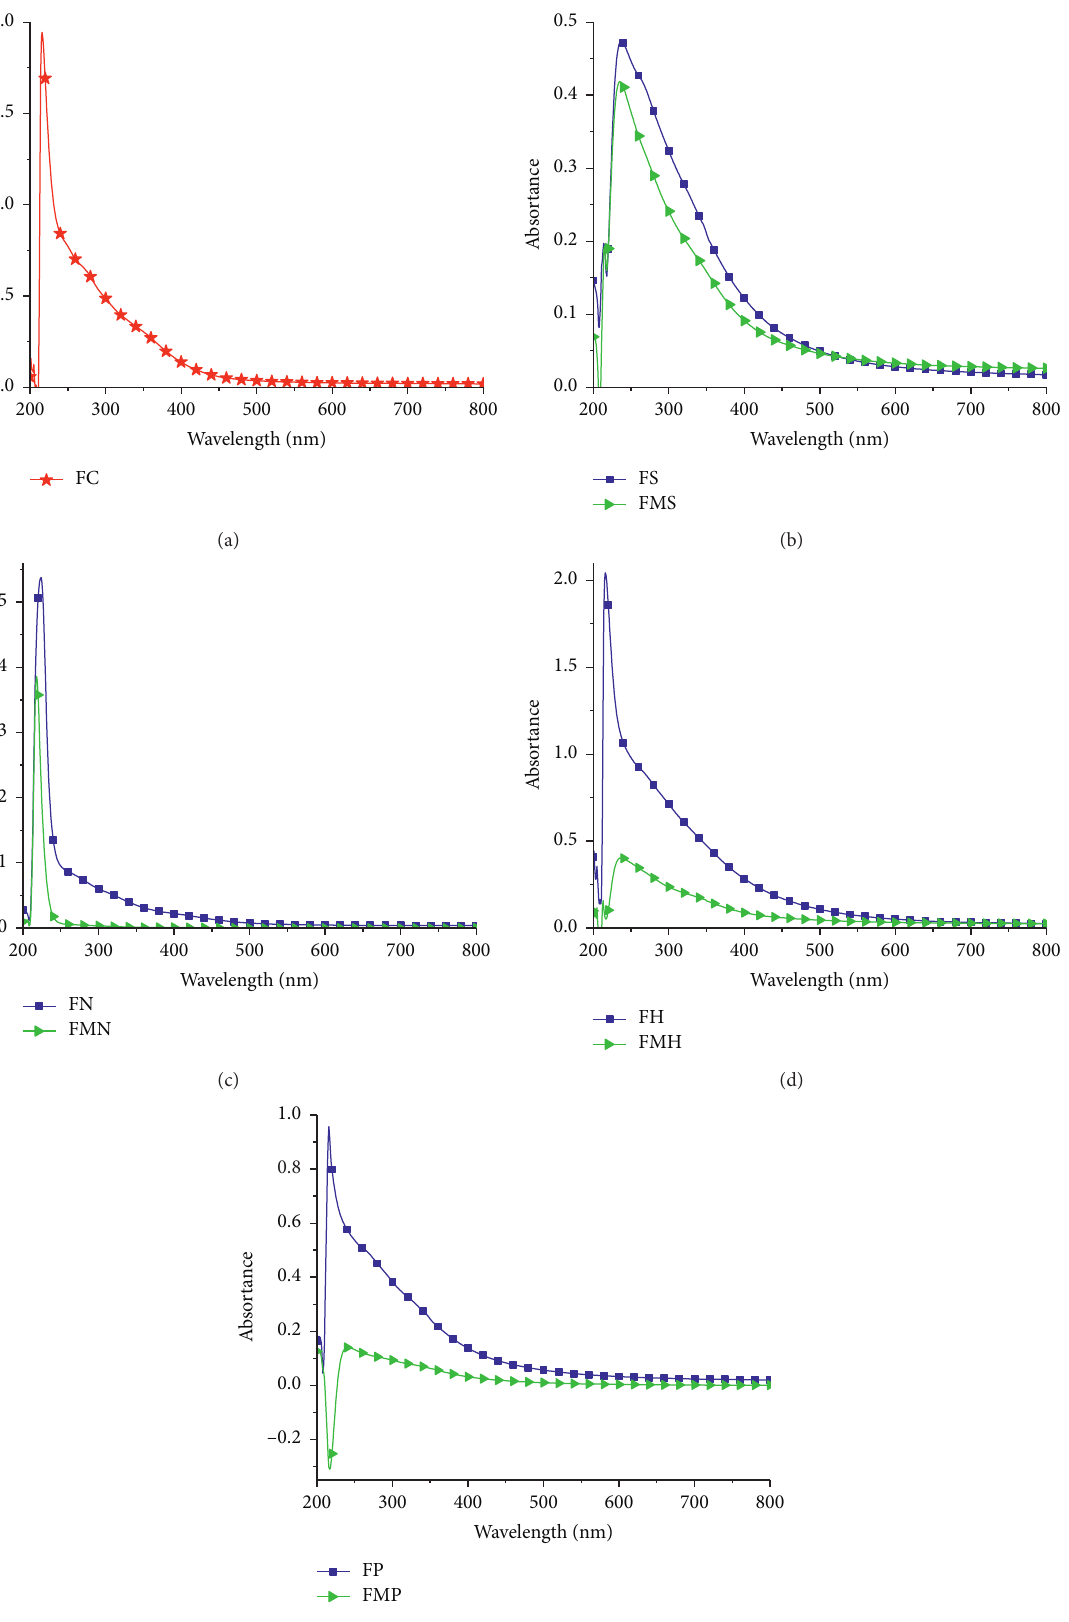
Figure 4: (a) UV-Vis of fulvic acid. UV-Vis of fulvic acid by (b) sulfuric acid precipitation, (c) nitric acid precipitation, (d) hydrochloric acid precipitation, and (e) phosphoric acid